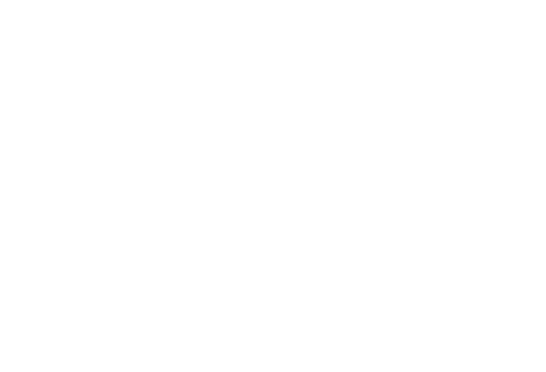
Figure 8. Cell viability of U87MG measured by 3-(4,5-dimethylthiazol-2-yl)-2,5-diphenyltetrazolium bromide (MTT) assay. Intact U87MG cells were used as the control. An ANOVA test was performed to determine statistical significance. No statistical significance was found between samples ( p - value <